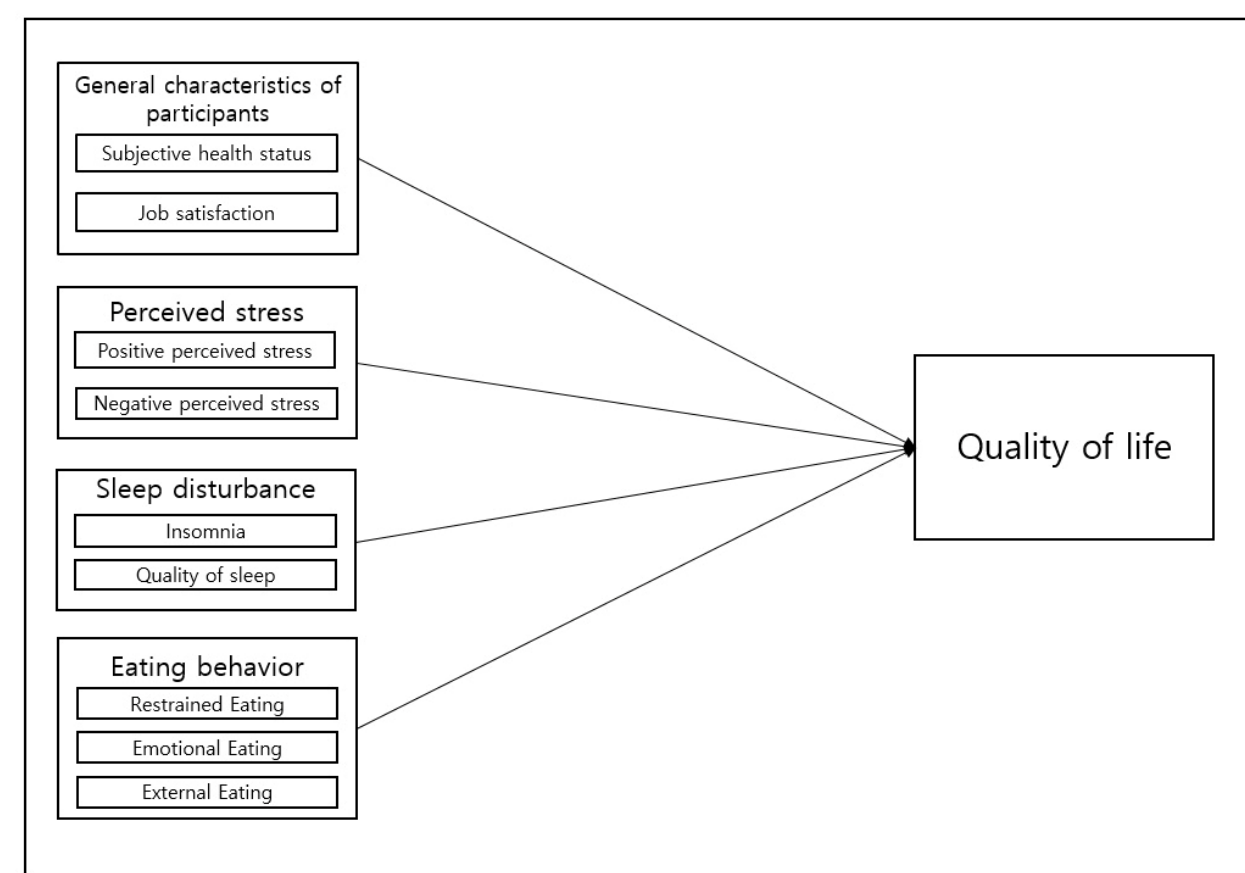
Figure 1. Conceptual framework of the study design.